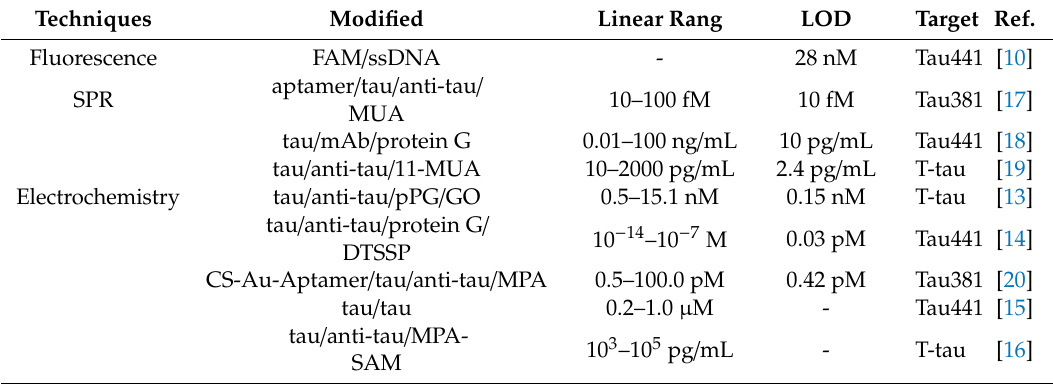
Table 1. A comparison of di ff erent biosensor techniques for tau detection.